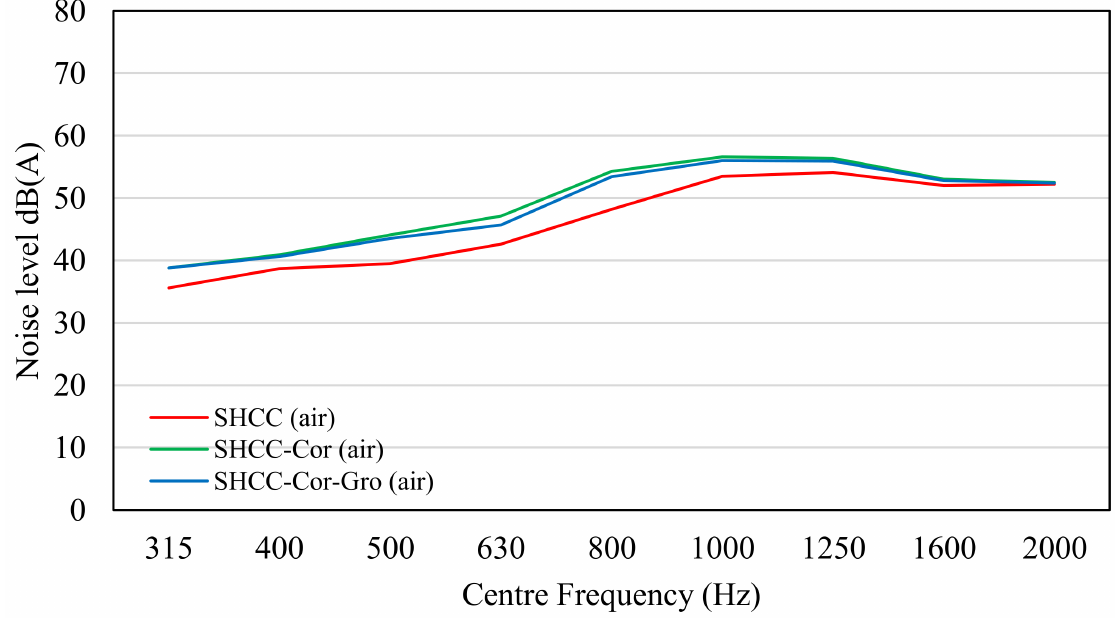
Figure 5. Noise level of SHCC, SHCC-Cor, and SHCC-Cor-Gro based on air